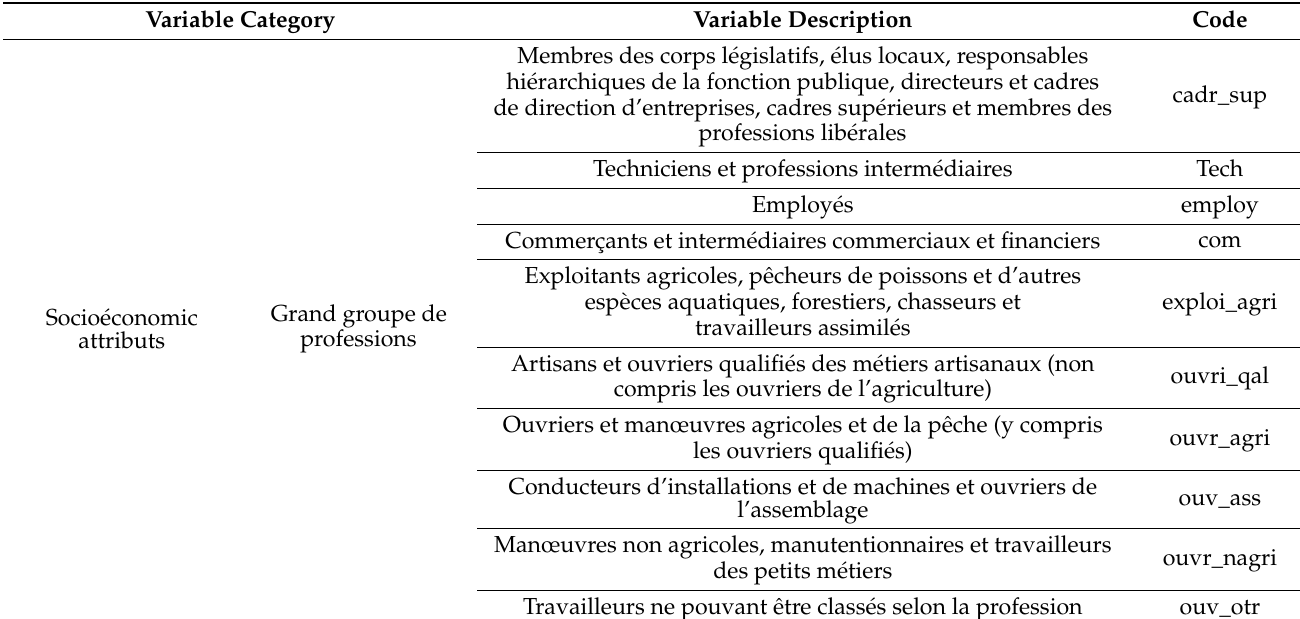
Table A1. Selected